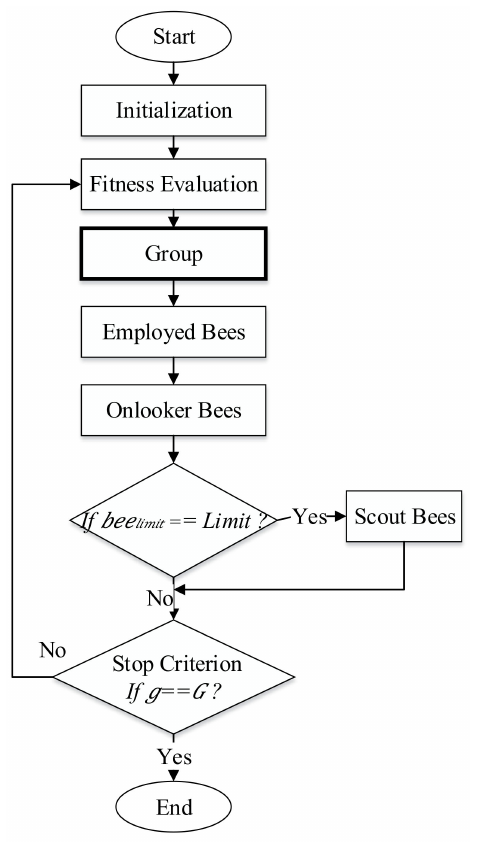
Figure 3. Flowchart of DGABC.